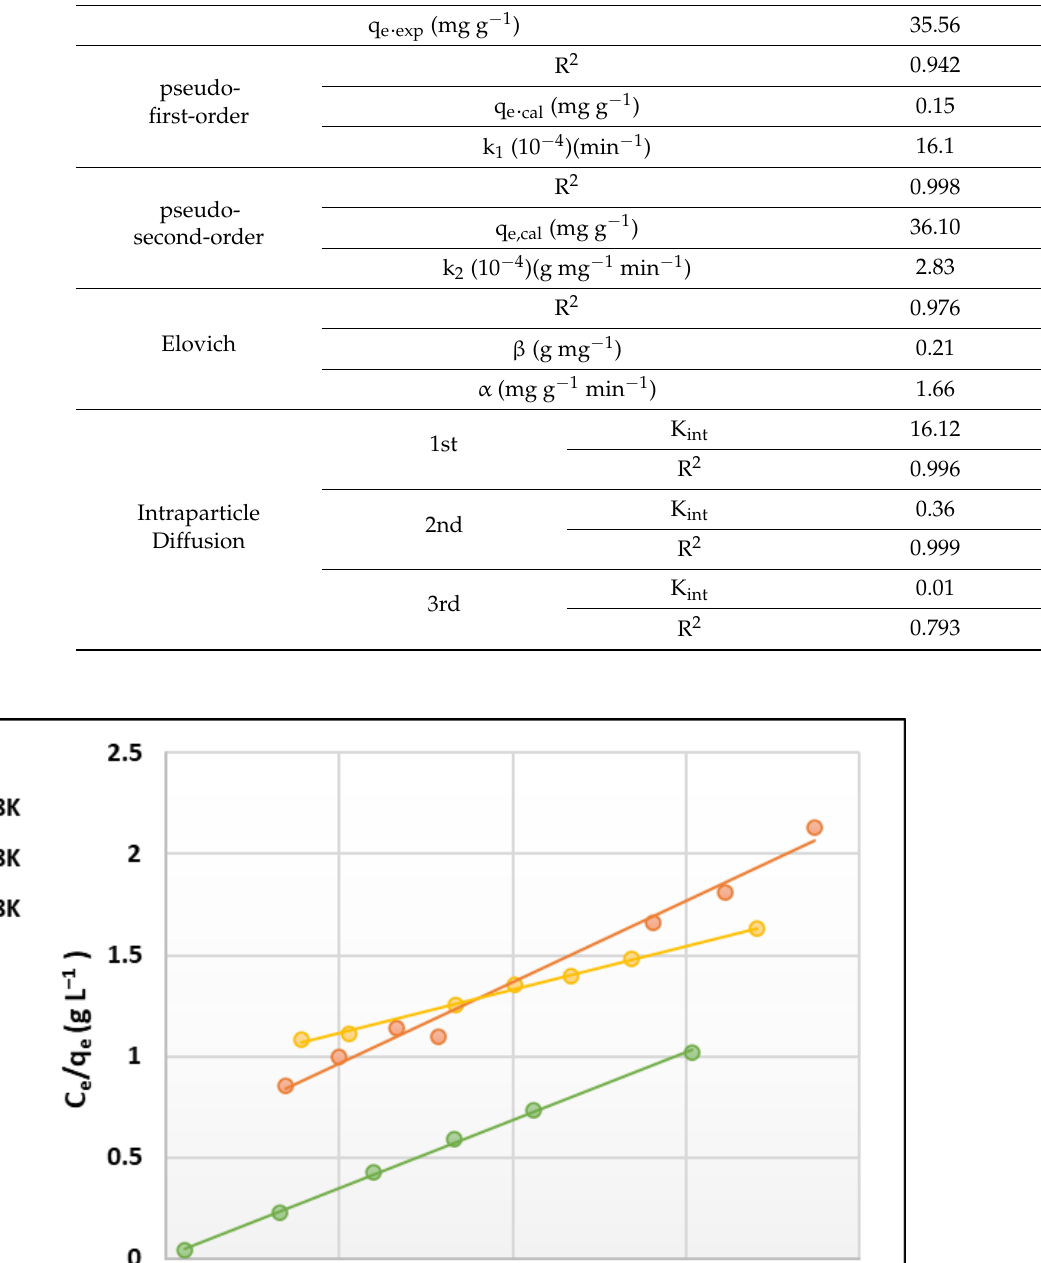
Table 3. Constants of kinetic models and coefficients of correlation for the 2Clph-BU-Cs adsorbent’s Table 4. Adsorption isotherm constants of CR dye by 2Clph - BU-Cs adsorbent (m = 0.01 g, C 0 = 30– 120 mg L −1 , V = 100 mL, pH = 4, and time = 48 h).